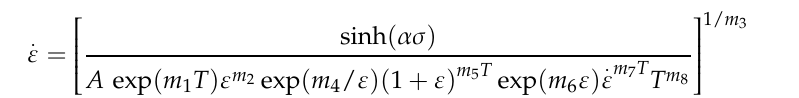
Figure 13. Relation between ln 𝜀̇ ∗ and ln 𝜀̇ in the modified Hensel–Spittel (mHS) equation.